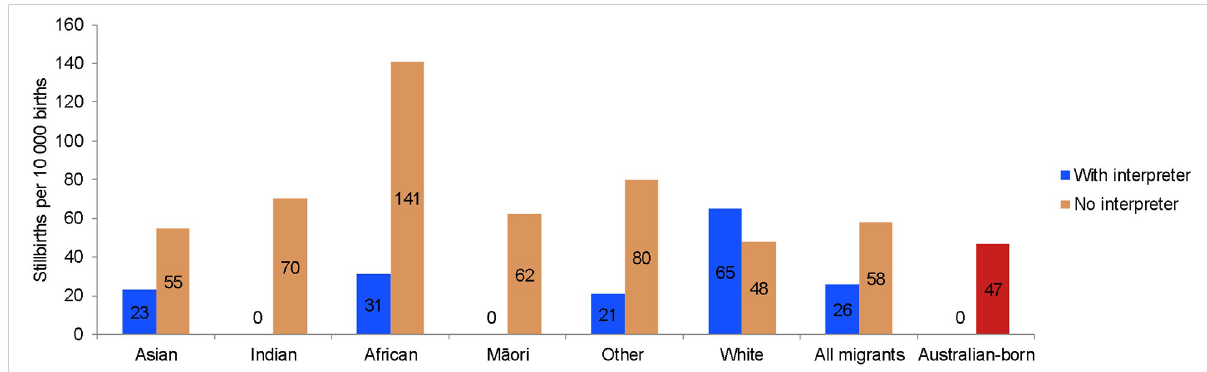
Fig 4. The cumulative incidence rates of overall SB according to interpreter service use (2005–2013). SB, stillbirth.